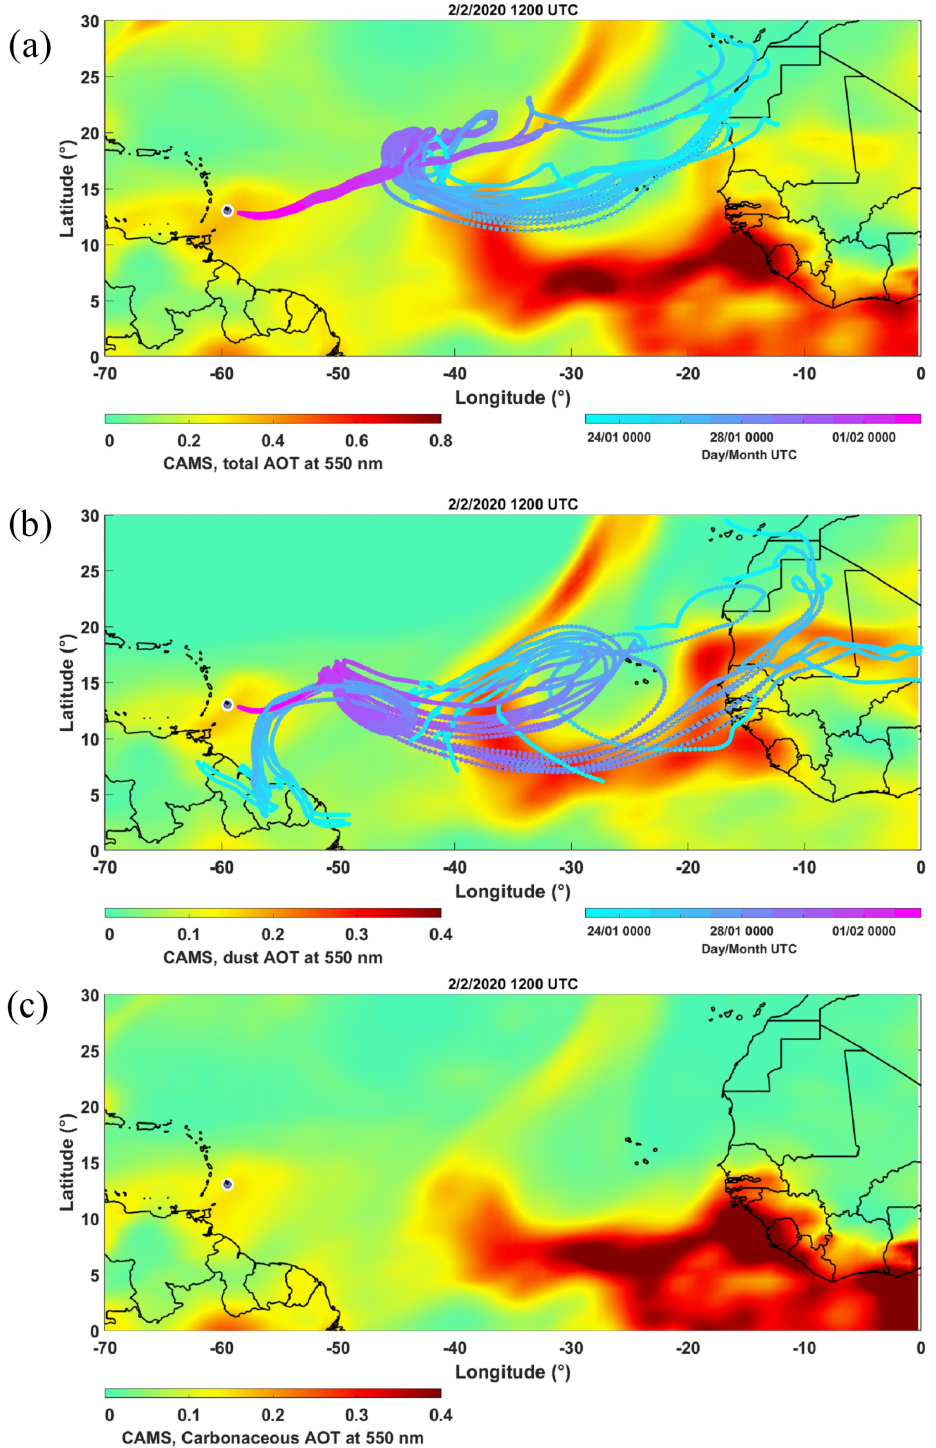
Figure 11. Aerosol optical thickness (AOT) derived from the CAMS numerical simulations on 2 February at 12:00UTC: (a) total AOT, (b) AOT of dusts, and (c) AOT of carbonaceous components (black carbon and organic carbon). The back trajectories computed via HYSPLIT in ensemble mode are plotted in panel (a) for an initial altitude of 800ma . m . s . l . , corresponding to rectangle ABCD in Fig. 1a and b for an initial altitude of 2250ma . m . s . l . , both over the flight area close to Barbados.